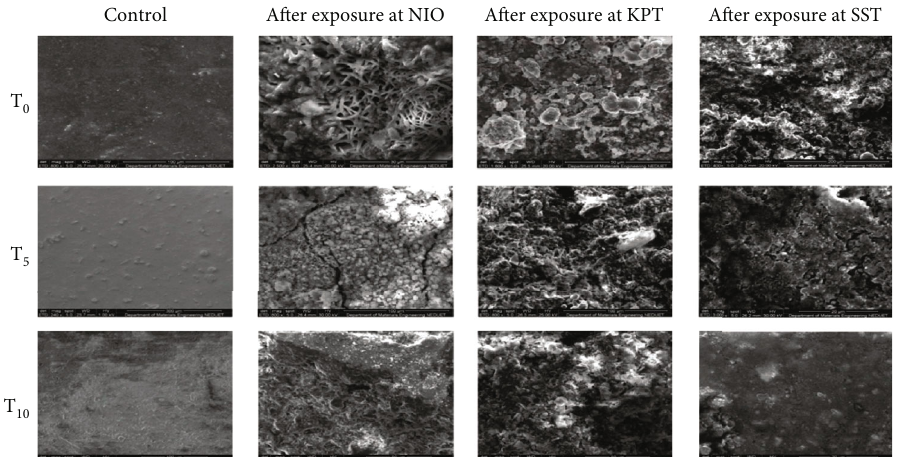
and T ) after 5 10